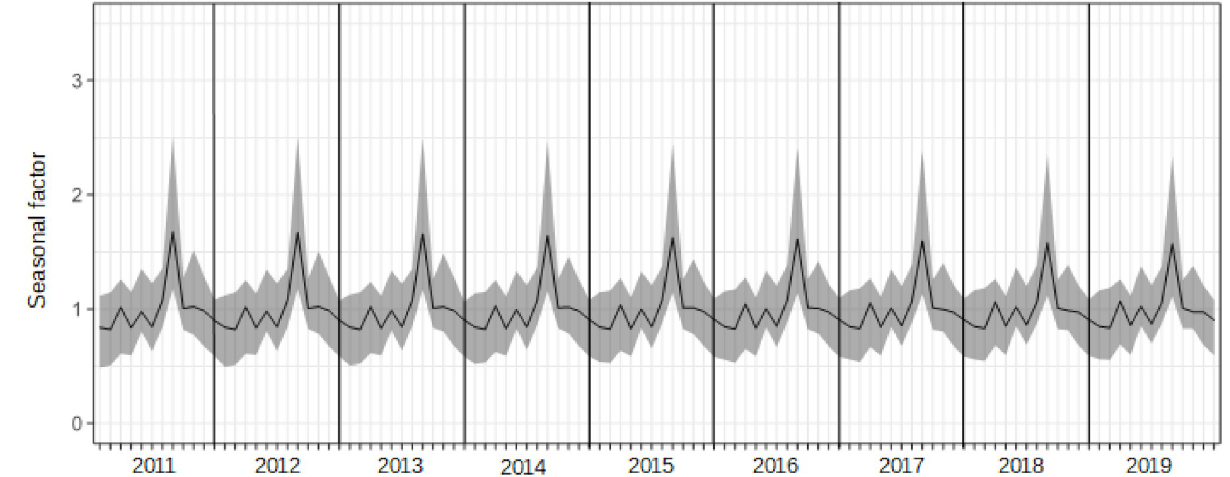
Fig 7. Range between maximum and minimum of seasonal factors among prefectures in domestic guests for tourism.